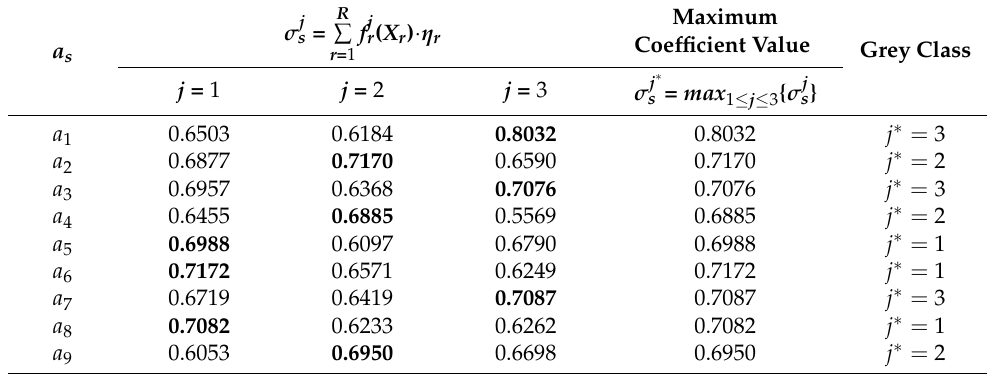
(cid:16) (cid:17) σ j s based on entropy weight.